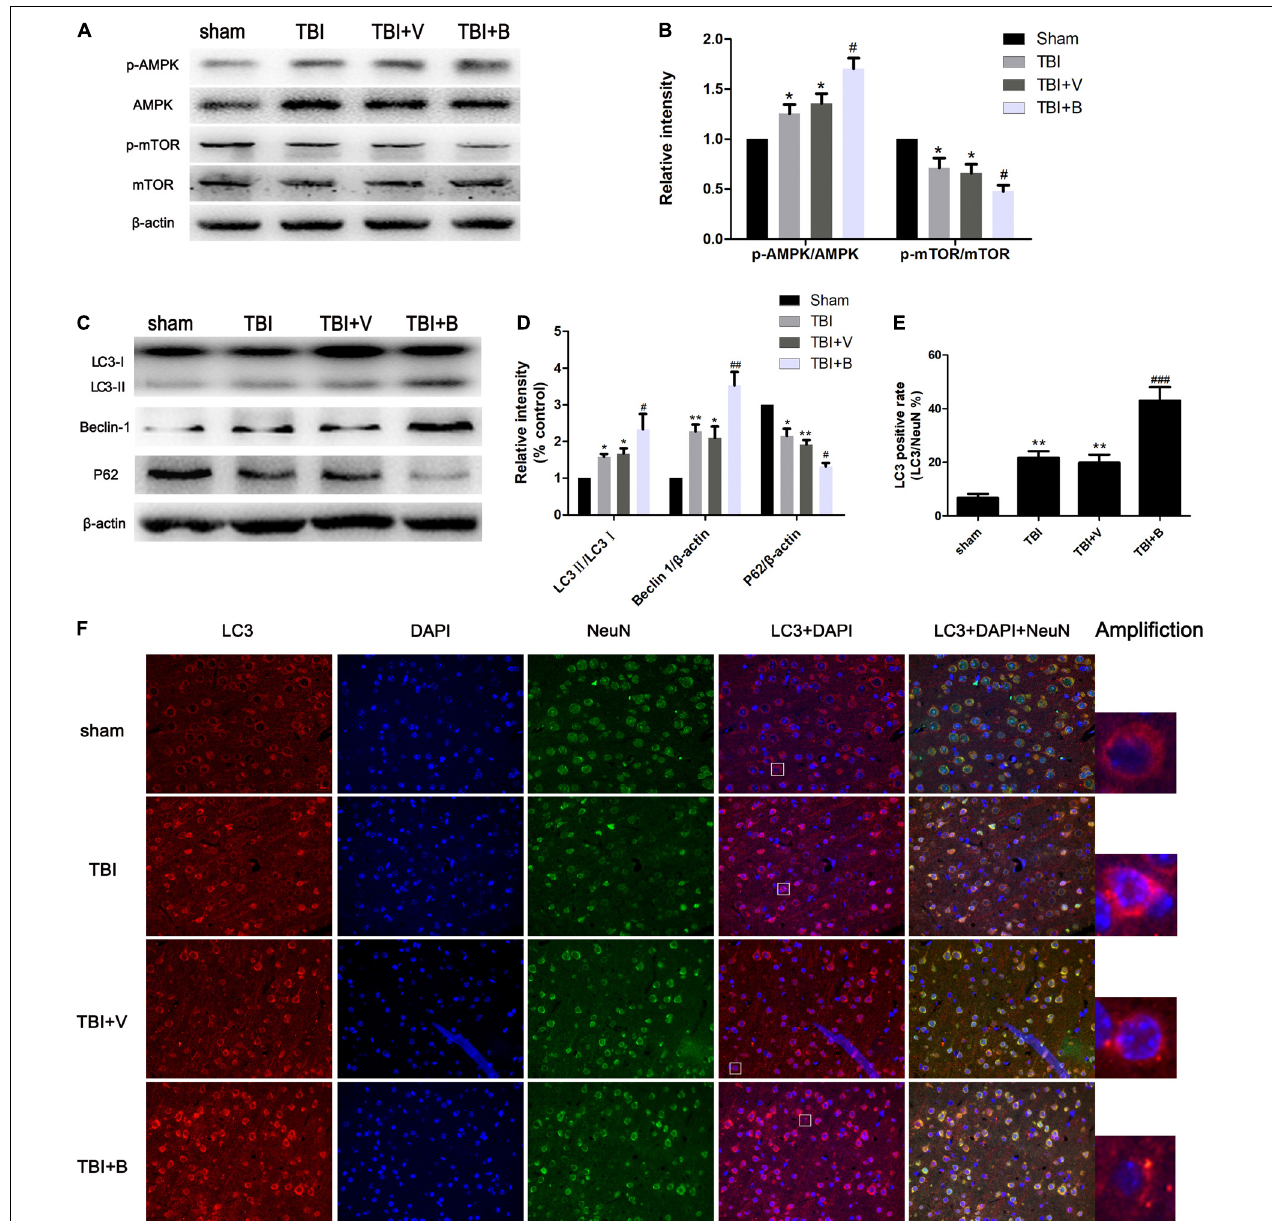
FIGURE 4 | Baicalin enhanced autophagy following TBI. (A,B) The western blot band and semiquantitative analysis of p-AMPK, AMPK, p-mTOR, mTOR. (C,D) The western blot band and semiquantitative analysis of LC3, Beclin 1, and p62. (E,F) Representative immunofluorescence staining and the percentage of LC3 positive rate in four groups. LC3-II fluorescence signal diffused in sham group. However, in TBI and Baicalin-treated groups, more LC3-II aggregations were observed. White rectangles in respective group were amplified to show the typical cells with LC3-II aggregation. Data are represented as mean ± SD ( n = 6 per group). ∗ P < 0.05 and ∗∗ P < 0.01 compared with sham group; # P < 0.05, ## P < 0.01, and ### P < 0.001 compared with the TBI + V group. Scale bar: 50 µ